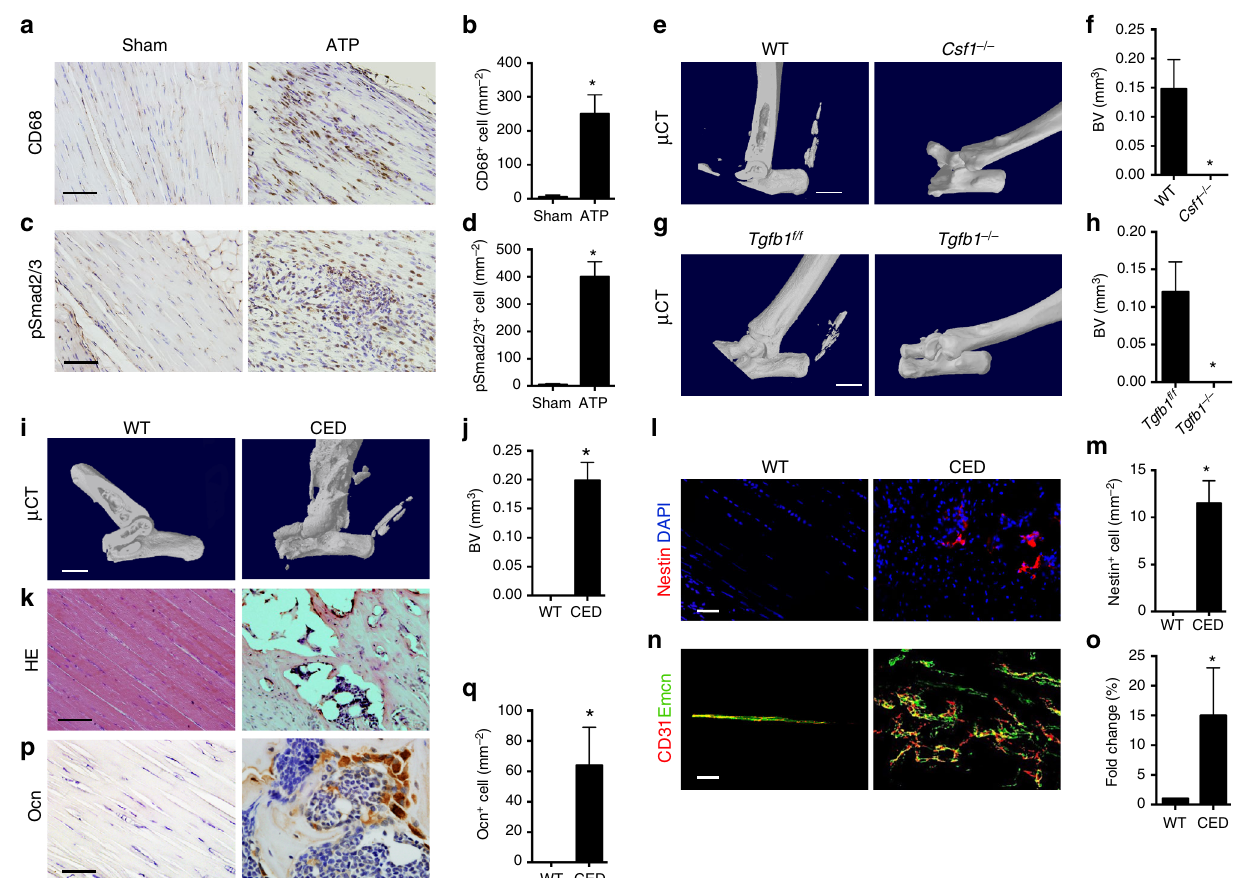
Fig. 3 Macrophages produce TGF- β to initiate HO. a – h High levels of active TGF- β were associated with increased macrophage four days after HO induction by ATP. a , c Immunostaining and b , d quantitative analysis of CD68 and pSmad2/3-positive cells in Achilles tendon two days after sham operation or ATP. Scale bar, 50 μ m. n = 8 per group. e Micro CT images and f quantitative analysis of HO bone volume in the Achilles tendons (sagittal view) in WT or CSF1 − / − mice 6 weeks after ATP. Scale bar, 2 mm. n = 8 per group g Micro CT images and h quanti fi cation of HO bone volume in the Achilles tendons (sagittal view) in Tgfb1 fl ox/ fl ox or LysM-cre :: Tgfb1 fl ox/ fl ox mice 6 weeks after ATP. Scale bar, 2 mm. n = 8 per group. e – q Transgenic expression of active TGF- β by Col I promoter induces HO. i Micro CT images of the Achilles tendon (sagittal view) of 4-month-old CED mice and WT littermates and j quantitative analysis of HO bone volume in Achilles tendon. Scale bar, 2 mm k H&E staining of Achilles tendon of 4-month-old CED mice and WT littermates. Scale bar, 50 μ m. l Nestin + (red) cells and m quanti fi cation in the ectopic bone marrow of CED and WT mice. Scale bar, 50 μ m. Blue indicates DAPI staining of nuclei. n CD31 + (red) and Emcn + (green) cells in the ectopic bone marrow. Scale bar, 100 μ m. Yellow indicates type H vessels. o Quanti fi cation of the fold change of type H vessels in CED mice compared to that of WT littermates. p Immunostaining and q quanti fi cation of Ocn + cells of in ectopic bone marrow in Achilles tendons of 4-month-old CED mice and WT littermates. Scale bar, 20 μ m. All data are shown as the mean ± s.d. n = 22 per group. * p < 0.05 as determined by unpaired Student ’ s